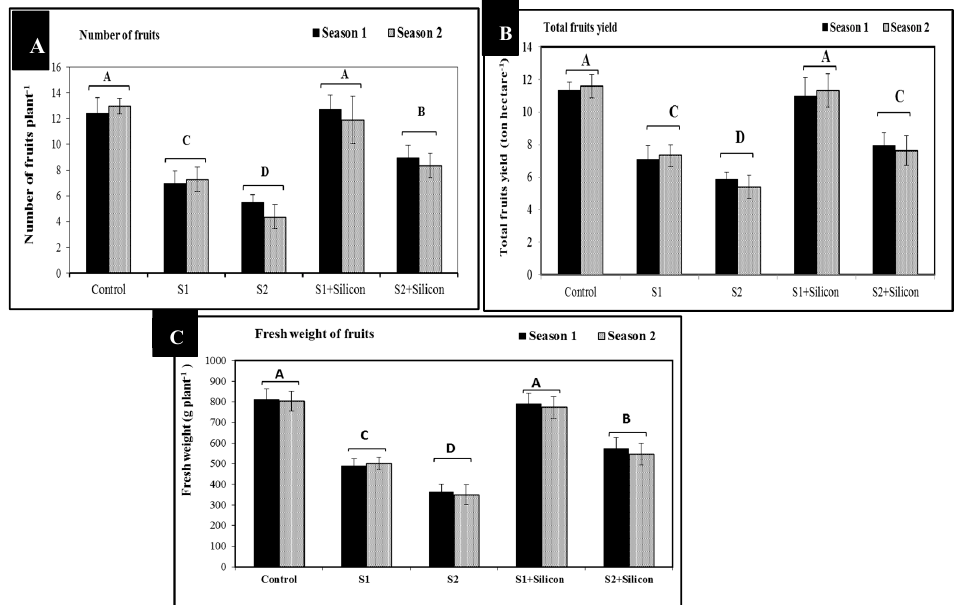
Figure 6. Effects of silicon on number of fruits plant − 1 ( A ), total fruit yield (ton hectare − 1 ) ( B ) and fruit fresh weight plant − 1 ( C ) in salt-stressed sweet pepper plants in the 2018 and 2019 seasons. S1: Salinity at 1500 ppm, S2: Salinity at 3000 ppm.